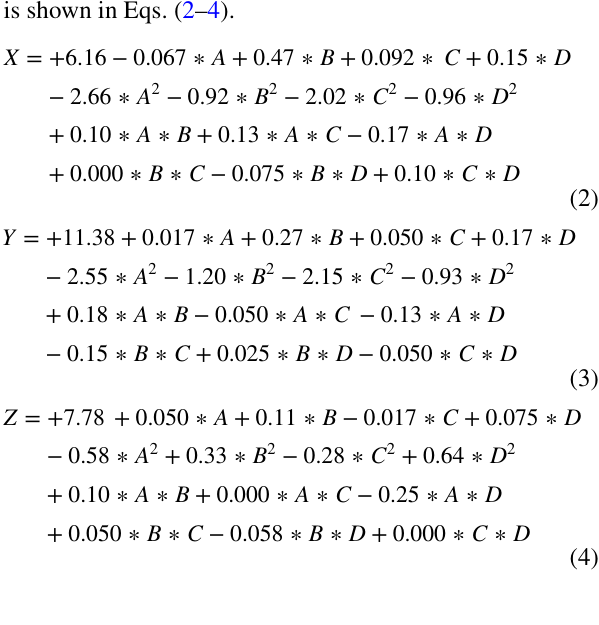
Table 2 Estimated regression coefficient and corresponding p value for cellulase, xylanase and CMCase production by A.